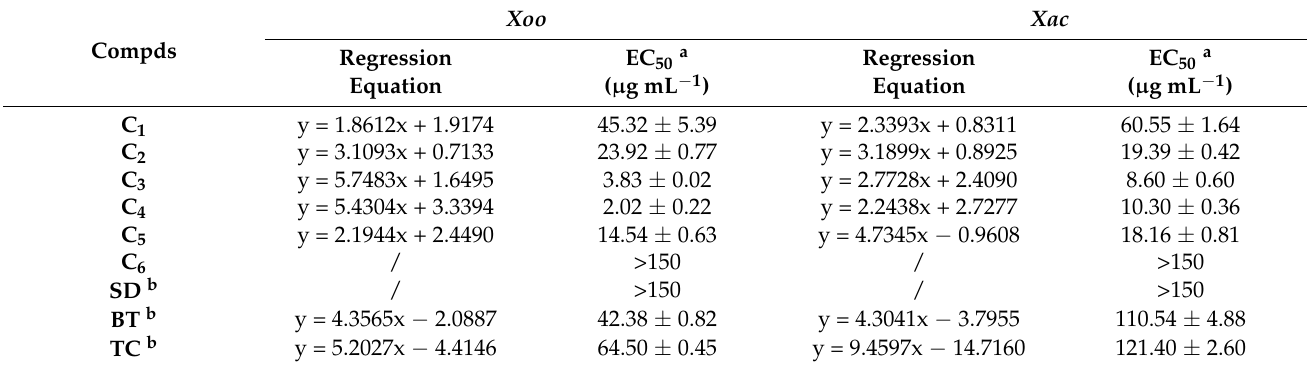
Table 3. In vitro antibacterial activities of target molecules C 1 − C 6 against plant pathogens.